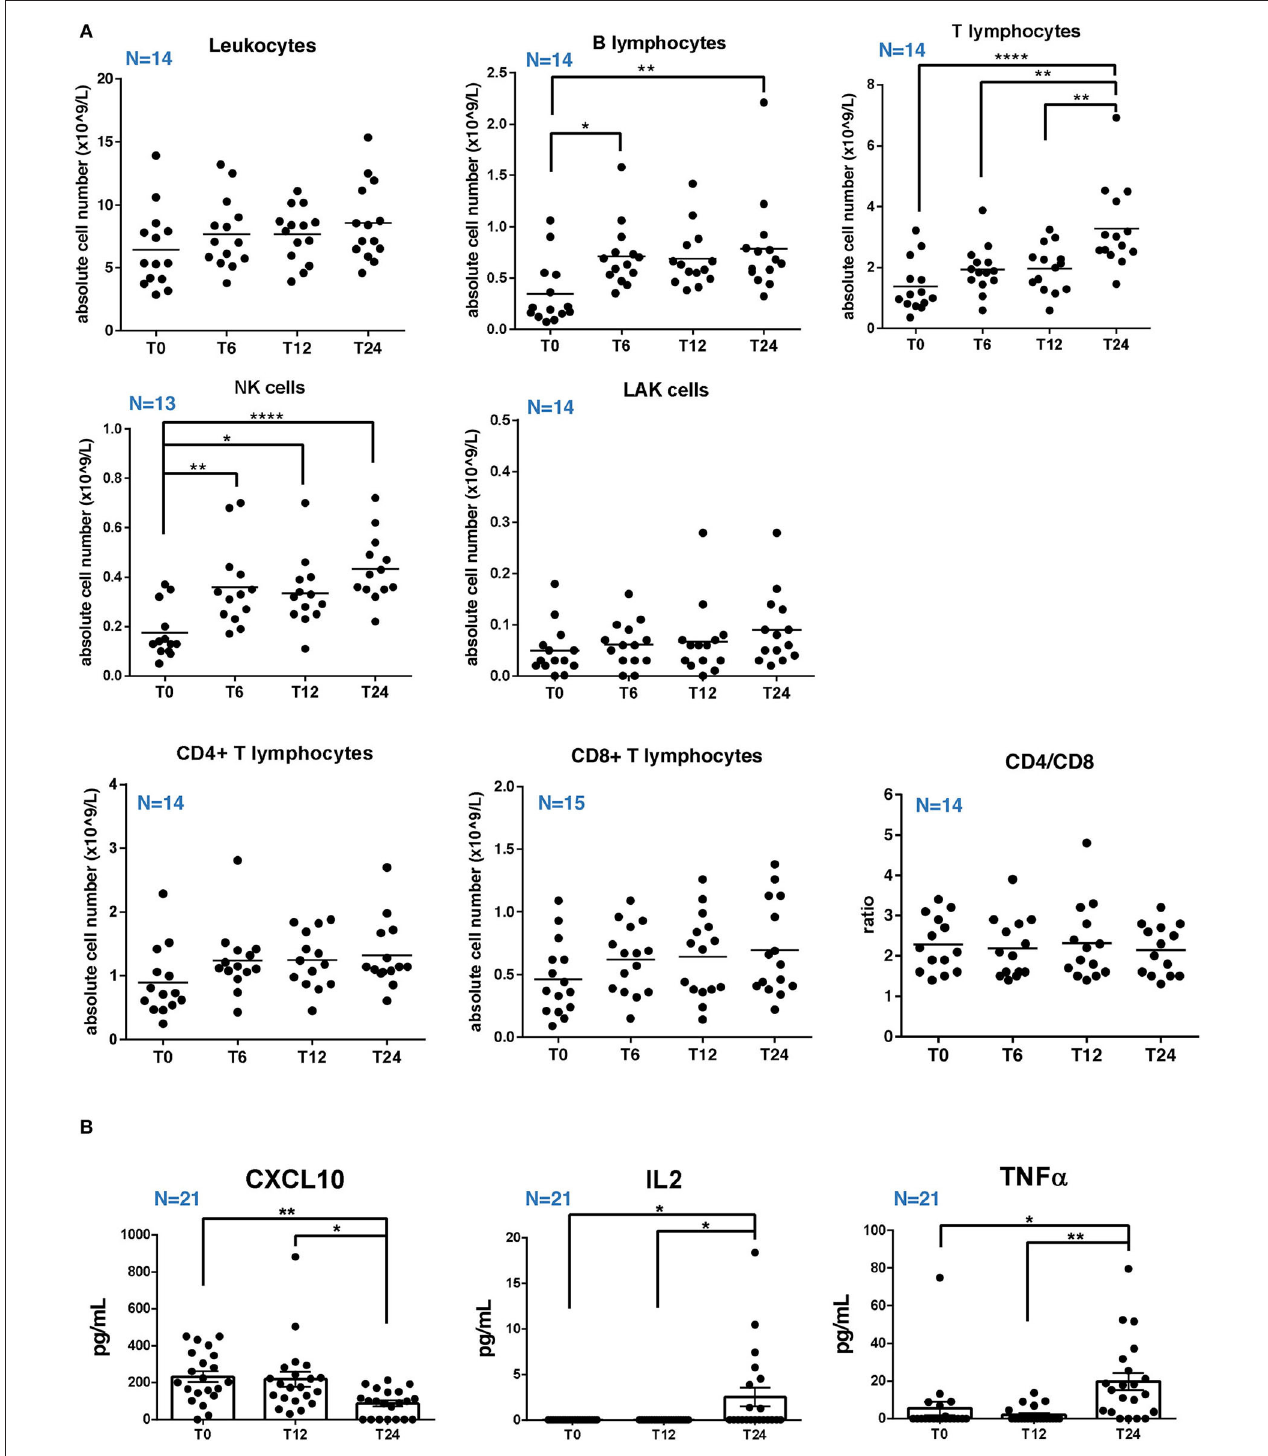
FIGURE 1 | Absolute cell counts of circulating lymphocytes and serum cytokines level in RRMS patients under natalizumab. (A) Percentage and absolute cell count of total T, B, natural killer (NK), lymphokine-activated killer (LAK) cells, and the ratio between CD4 and CD8T cells (CD4/CD8) at baseline (T0) and after 6, 12, or 24 (T6, T12, and T24) months of natalizumab (NTZ) treatment. Each dot represents a patient. Patients’ number is shown in blue for each graph. Mean ± SEM is reported. Statistical significance was determined by one-way ANOVA followed by post-hoc Tukey test (* p < 0.05; ** p < 0.01; and **** p < 0.0001). (B) Concentration (pg/ml) of CXCL10, TNF α , and IL2 in serum of patients with RRMS at T0 or at T12 and T24 of NTZ treatment. Each dot represents a patient. Patients’ number is shown in blue for each graph. Mean ± SEM is reported. Statistical significance was determined by one-way ANOVA followed by post-hoc Tukey test (* p < 0.05; ** p < 0.01).